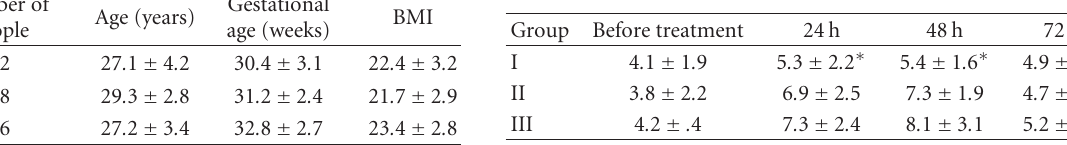
Table 1: Demographic characteristics ( x ± s ). Table 2: Blood glucose levels before and after dexamethasone therapy ( x ± s mmol/L).